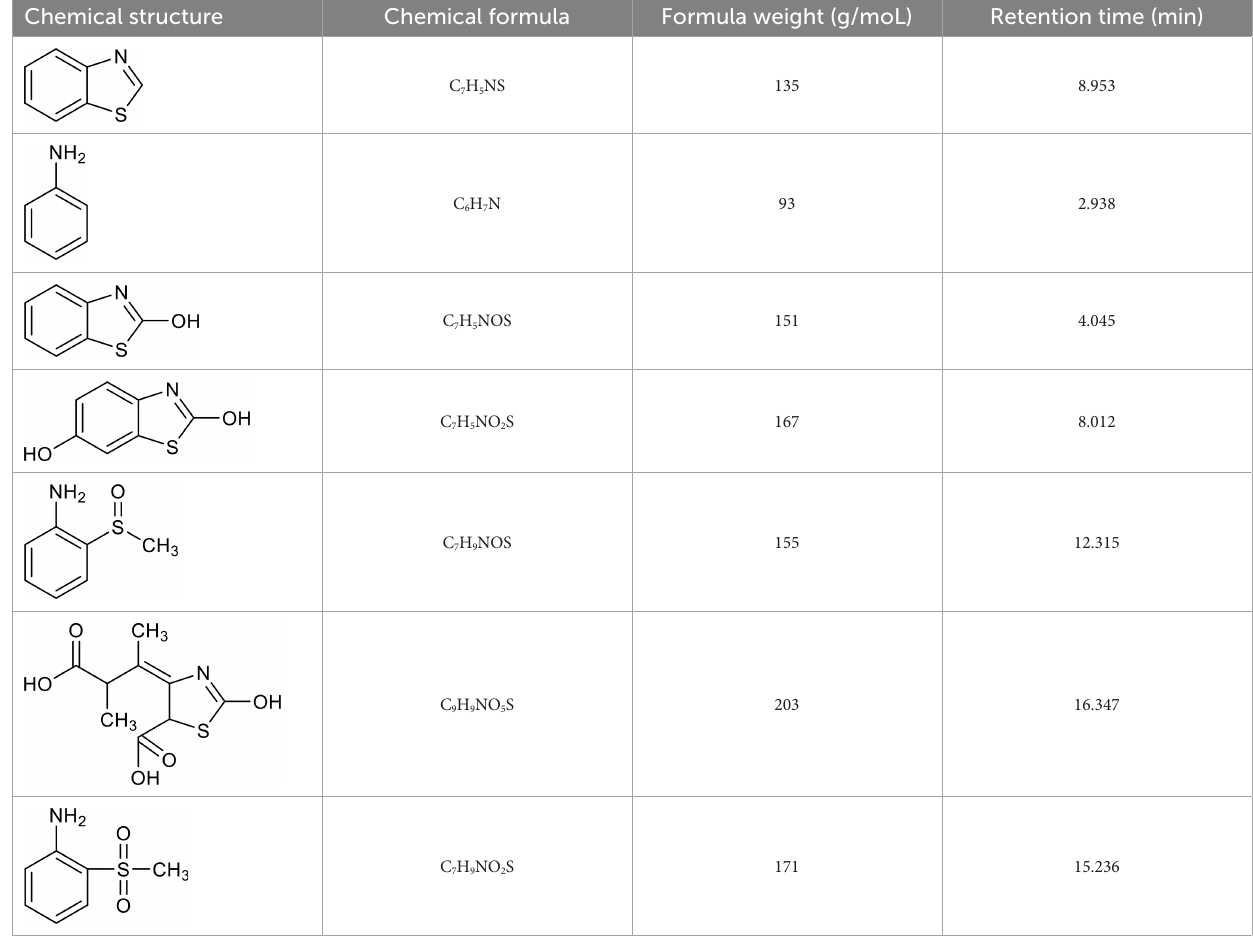
TABLE 3 List of degradation pathway compounds. Chemical structure Chemical